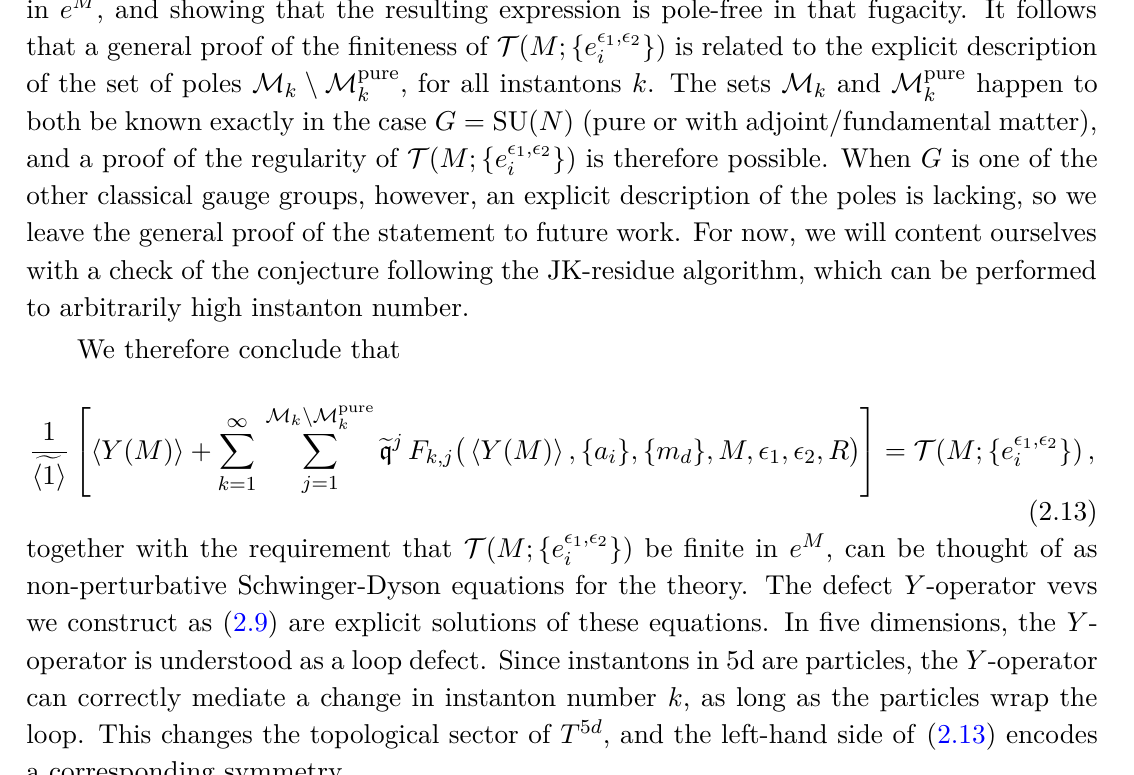
Figure 1 . The black crosses denote poles in the set M pure the red dot denotes a pole in the set M k \ M pure integrand. On the left, we show a possible contour for the computation of the 5d partition function at k = 1 , say for a SU(3) theory. Note that by the JK prescription, we must in particular enclose the new pole in red. Remarkably, it is equivalent to trade this contour for the one on the right, which now only encloses the poles in the set M pure on the right, the integrand will now contain insertions of new Y -operators, with an instanton shift of one unit to account for the missing